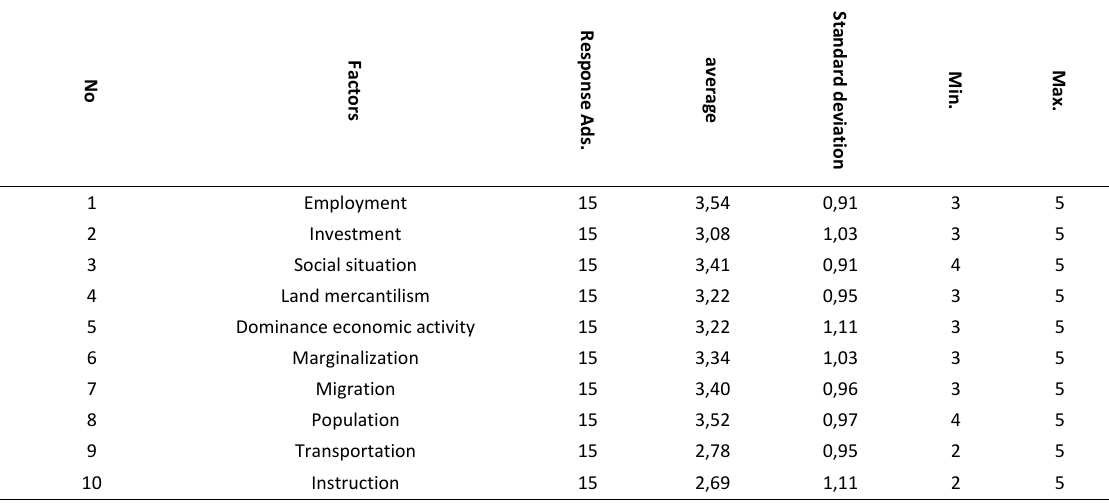
Table 4: Phase 2 of the fuzzy method in developing indicators determining the mechanisms affecting urban development